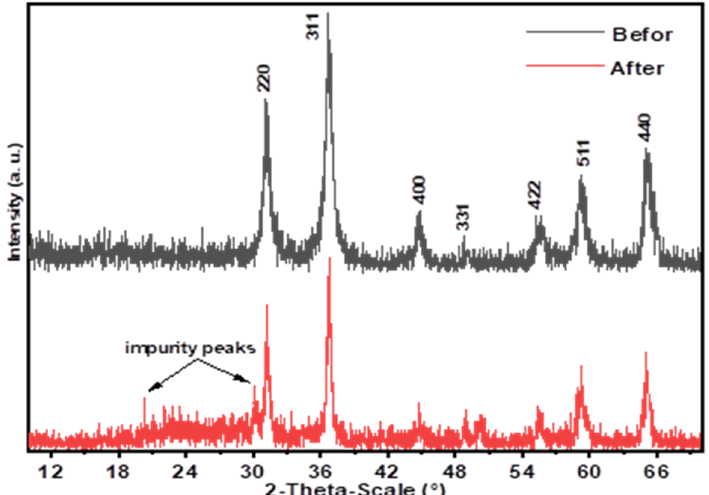
Fig. 12. XRD patterns of MSS sample before and after applying the recyclable experiment.